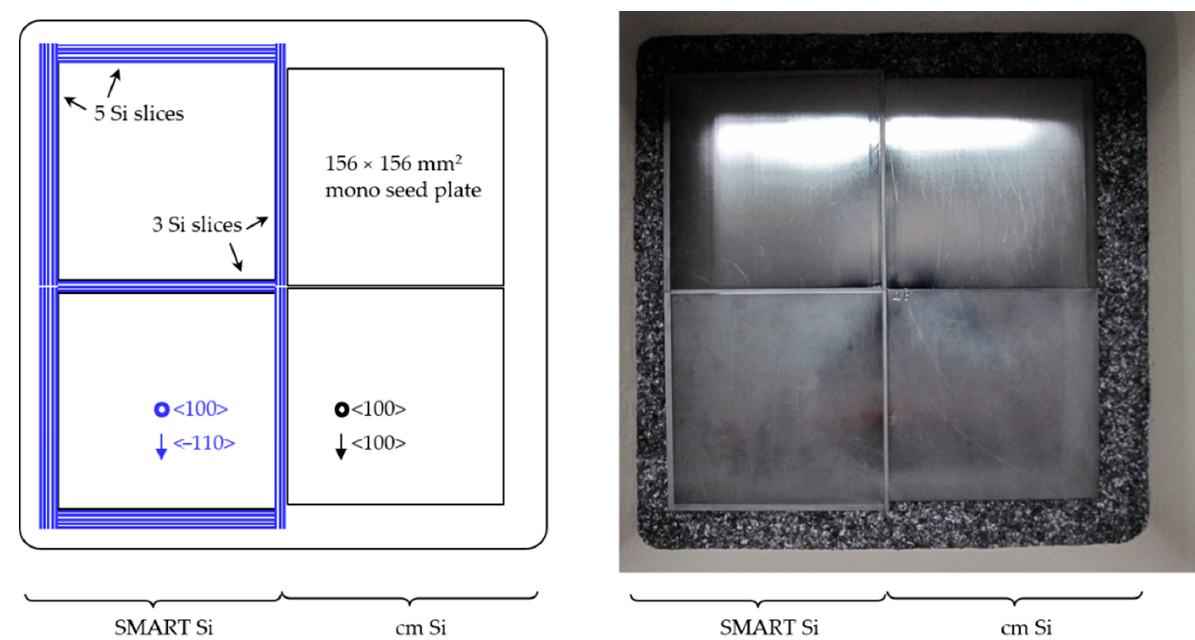
Figure 1. Sketch of the seed configuration with SMART and cm Si approach in one crystallization ( left ) and view into the crucible ( right ).